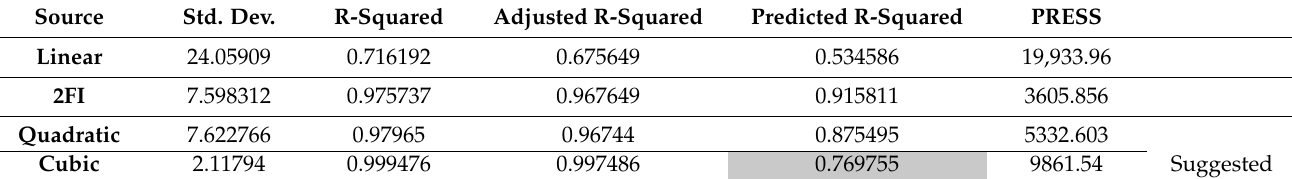
Table 2. Statistical parameters based on different regression fit models and R-factors for sensitivity